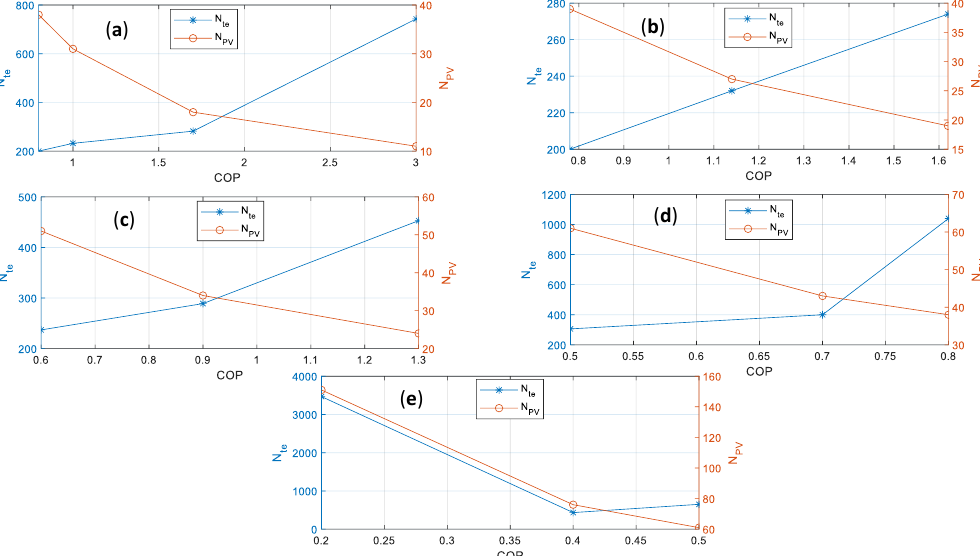
Figure 8. Variation of the number of the TE modules and PV panels versus COP for cooling mode of operation: ( a ) ΔT = 9.6 °C; ( b ) ΔT = 12 °C; ( c ) ΔT = 19.2 °C; ( d ) ΔT = 28.8 °C; and ( e ) ΔT = 38.3 °C.